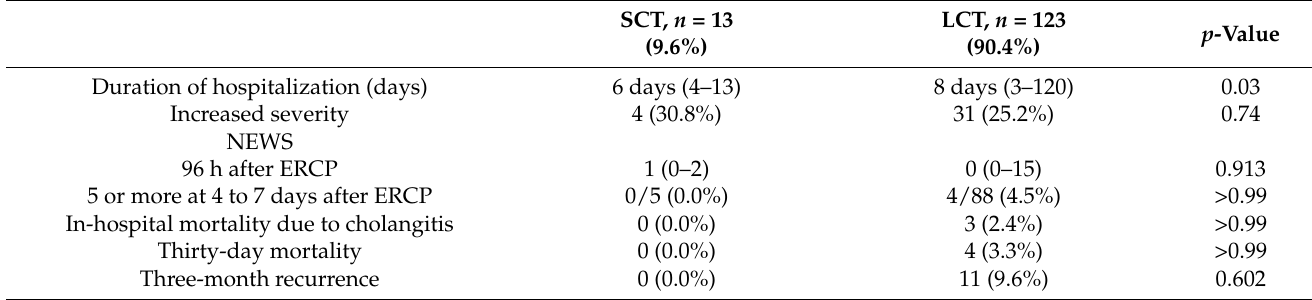
Table 7. Clinical outcomes in positive blood culture